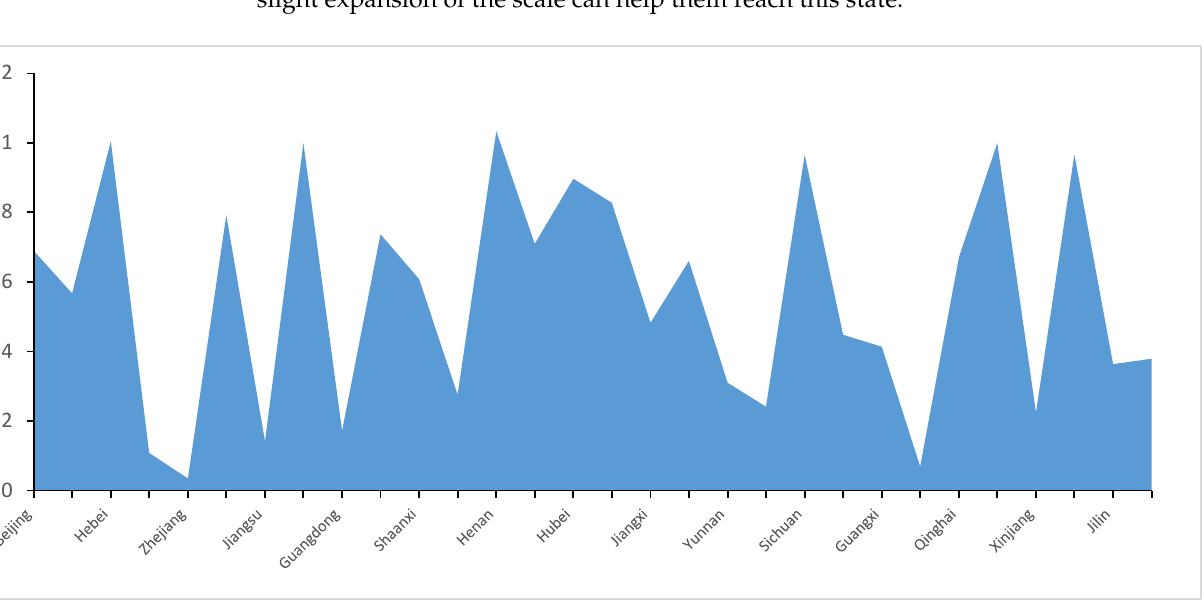
Figure 2. Technical efficiency and scale efficiency of 30 cities.